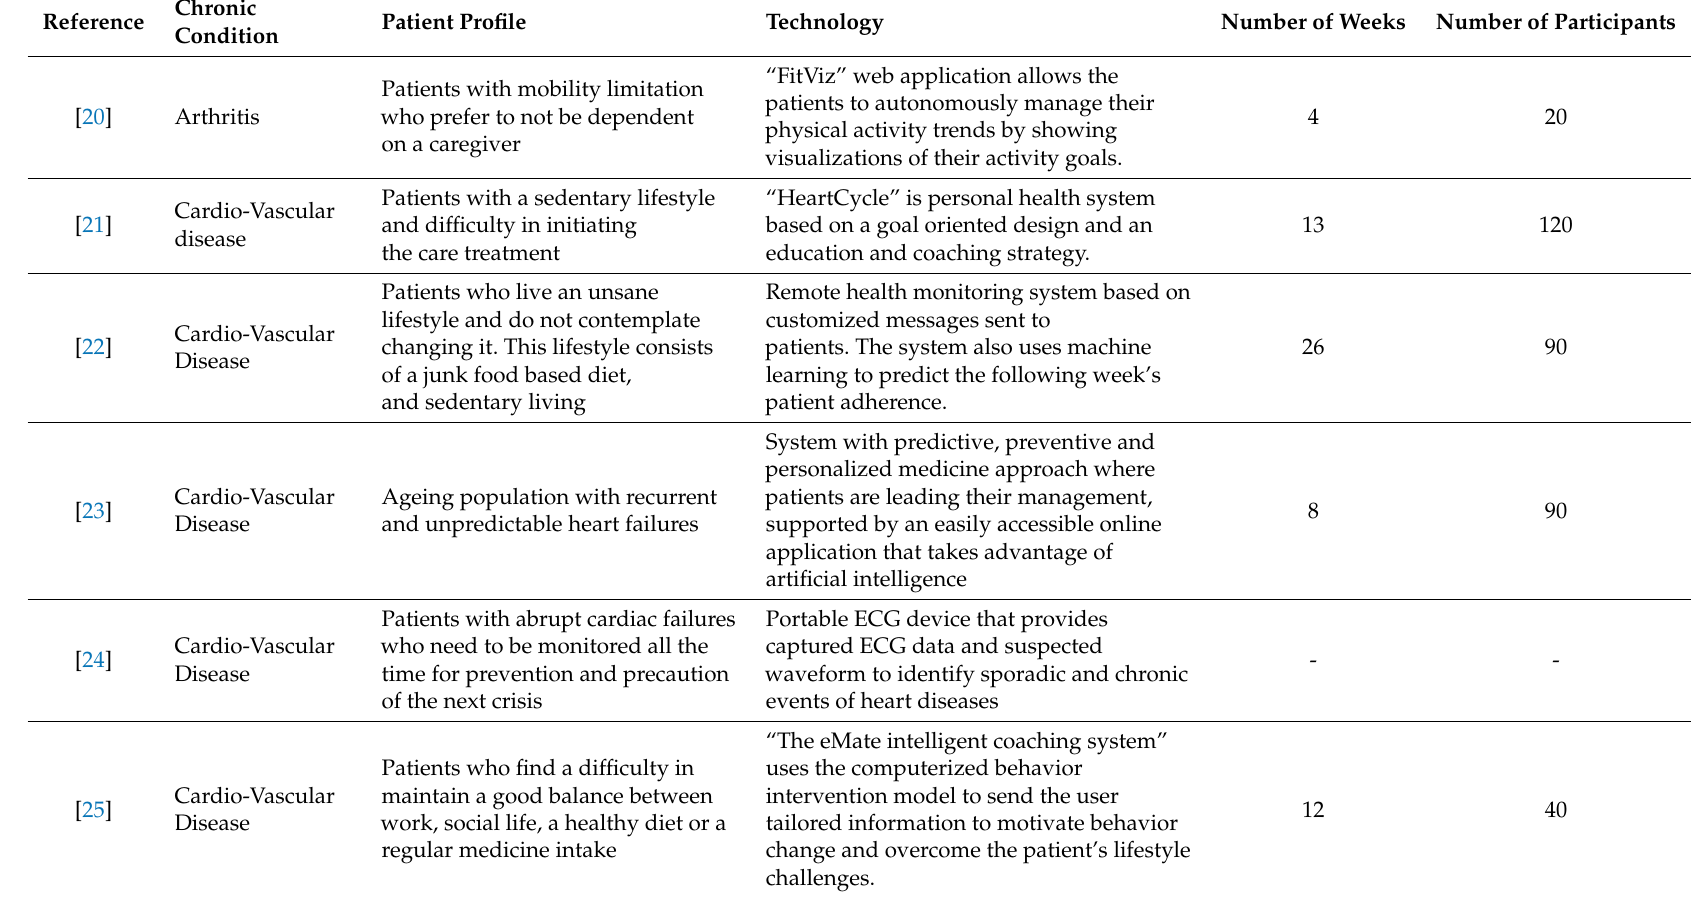
Table 1. Overview of the 31 papers included in the